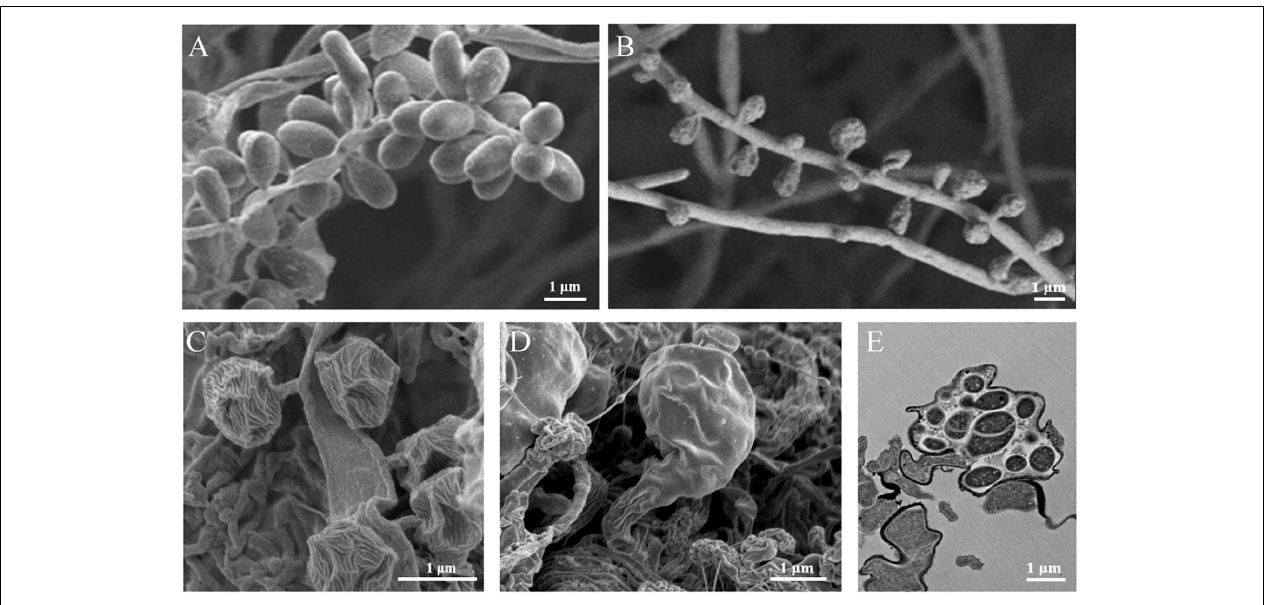
FIGURE 1 | Morphologies of the isolated Ktedonobacteria strains. Scanning electron micrographs of strain Thermosporothrix hazakensis SK20-1 T (A) , Thermogemmatispora onikobensis ONI-1 T (B) , Ktedonobacter racemifer SOSP1-21 T (C) , and Dictyobacter aurantiacus S27 T (D) , indicating the exospores (A–C) or sporangia (D,E) formed by these strains. (E) Transmission electron micrographs of the thin-sectioned sporangium formed by strain Dictyobacter aurantiacus S27 T . Bars: 1 µ